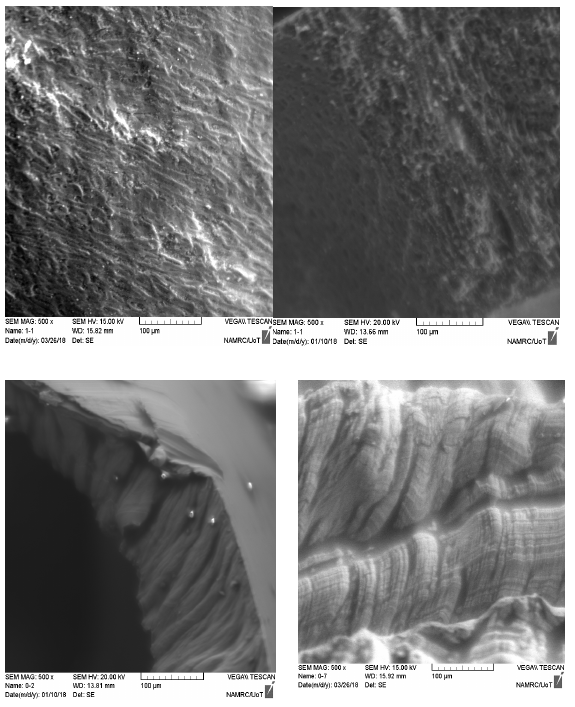
Fig. 7. SEM images for the ZVI (top) and ZVAI (bottom) sorbents before and after the reaction with